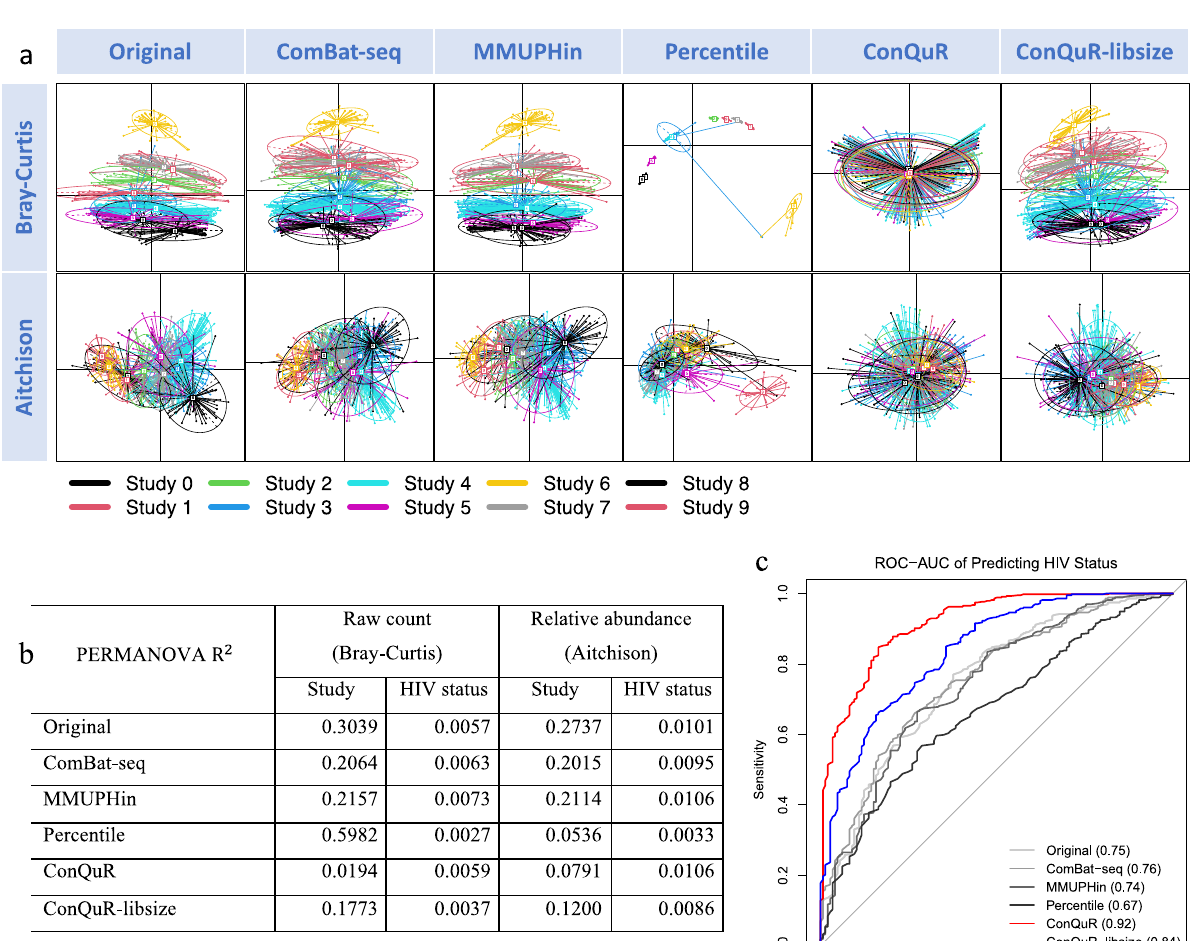
Fig. 3 | Evaluation on the CARDIA data. a PCoA plots clustered by batch ID (corresponding colors are shown at the bottom within the graph), based on Bray- Curtis dissimilarity on raw count data (top panel), Aitchison dissimilarity on the corresponding relative abundance data (middle panel), and GUniFrac dissimilarity on the corresponding relative abundance data (bottom panel). Each point repre- sentsasampleand eachellipserepresentsabatch,withthecentroidindicatingthe mean.Asanellipseconnectsthe95%percentileofpointsforeachbatch,thesizeof theellipseindicatesthedispersion,andtheangleindicateshigher-orderfeaturesof the batch. Better alignment of the ellipses is preferred. b Proportions of data